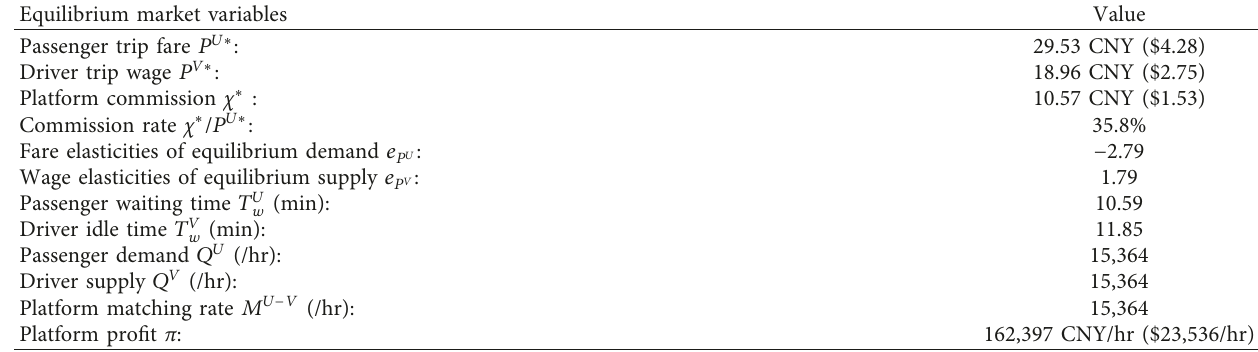
Table 2: Equilibrium market variables under profit maximization.